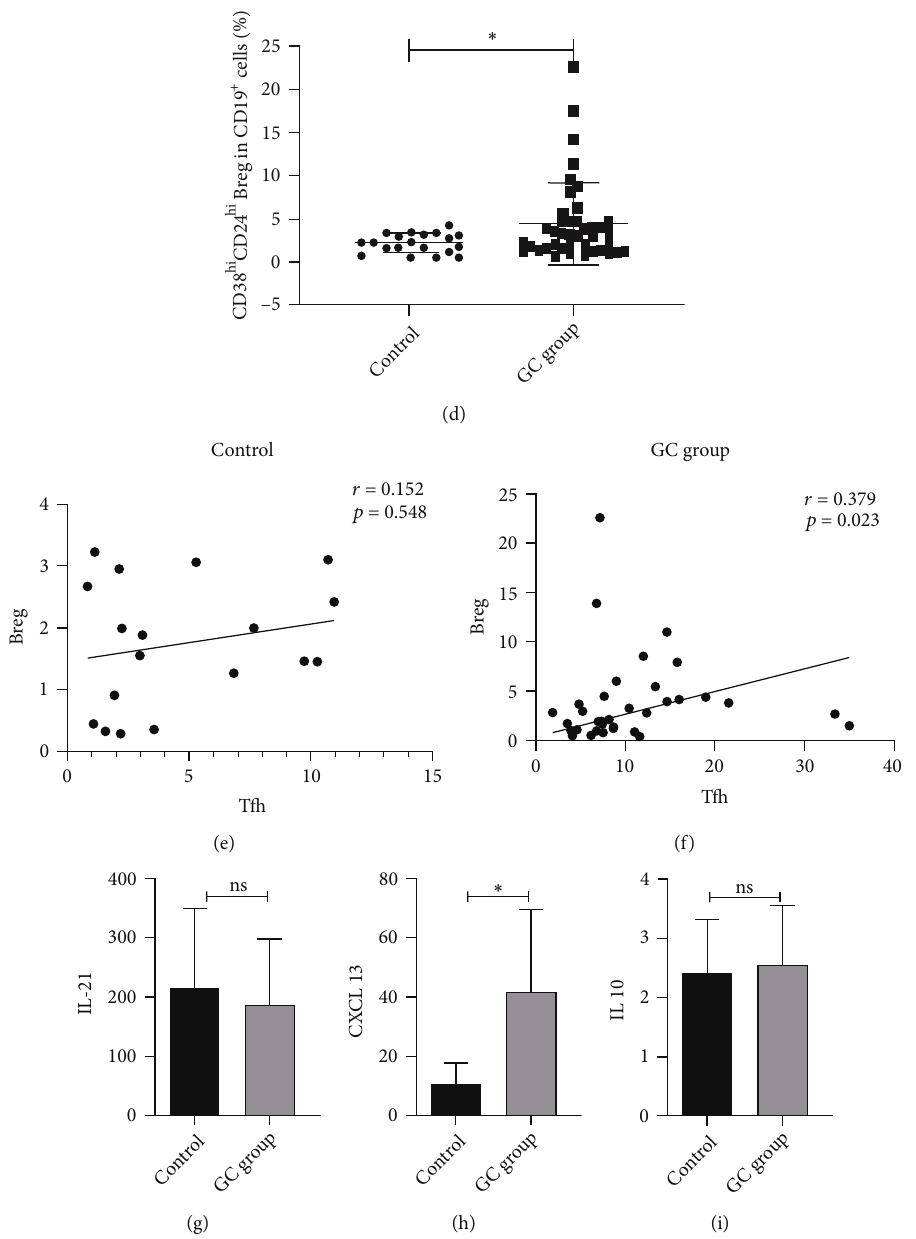
Figure 2: Proportion of Tfh and Breg cells in gastric cancer patients. Blood samples were collected from 36 cases of gastric cancer patients and 18 cases of healthy people. Representative fl ow cytometric results were shown. Tfh cells were classi fi ed as CXCR5 + CD4 + T cells (a), while Breg cells were classi fi ed as CD19 + CD24 hi CD38 hi cells (c). Compared to control individuals, signi fi cantly increased percentage of Tfh cells (b) and Breg cells (d) was found in gastric cancer patients ( P < 0 : 05 ). A positive association between Tfh% and Breg% was found in gastric cancer patients (e, P < 0 : 05 ), rather than in the healthy group (f, P > 0 : 05 ). Higher CXCL13 level was in the gastric cancer group than in the healthy group (g, P < 0 : 05 ). IL-21 and IL-10 levels have no signi fi cant di ff erence (h and i, P > 0 : 05 ). Tfh: follicular help T cells; Breg: regulatory B cells; CXCL13: C-X-C motif chemokine ligand 13; IL-21: interleukin-21; IL-10: interleukin-10;